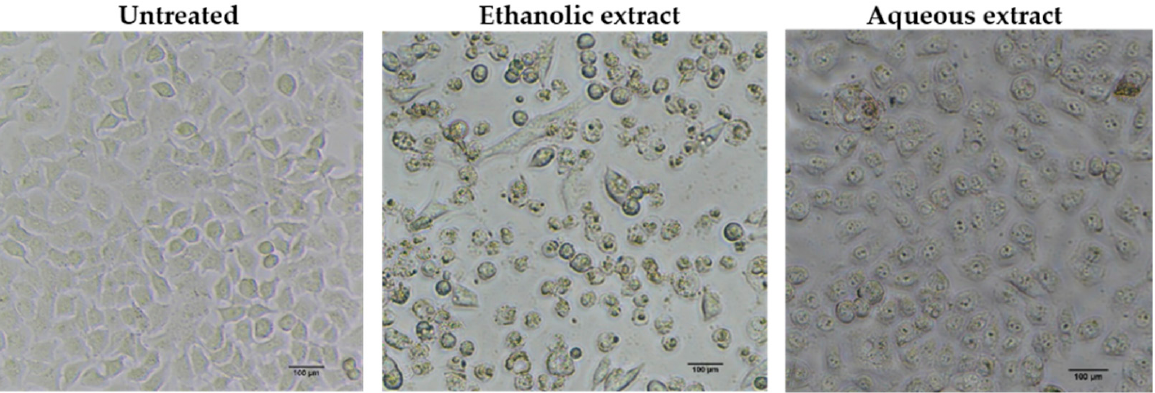
Figure 5. Morphological characteristics of apoptosis were detected in the cells after treatment with 250 µg/mL of red jasmine rice ethanolic extract and 3000 µg/mL of red jasmine rice aqueous extract for 48 h, when compared to untreated cells.